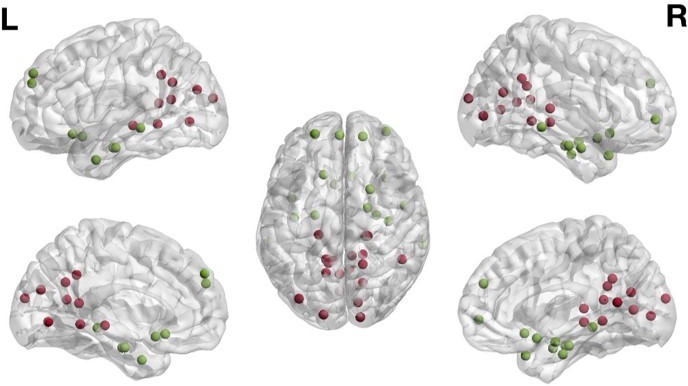
Network regions of interest.Posterior medial network (PMN) and anterior temporal network (ATN) regions of interest (Ranganath and Ritchey, 2012): PMN (red), ATN (green).